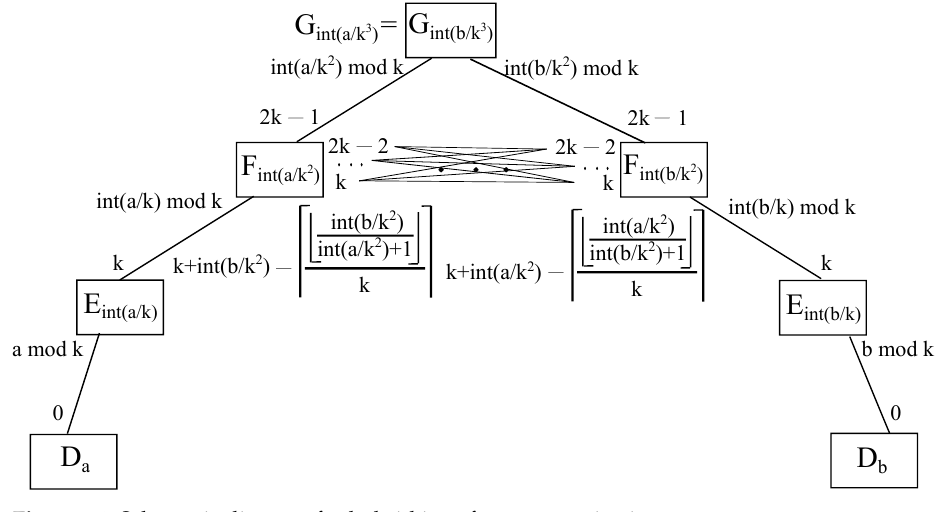
Figure 14. Schematic diagram for hybrid interfog